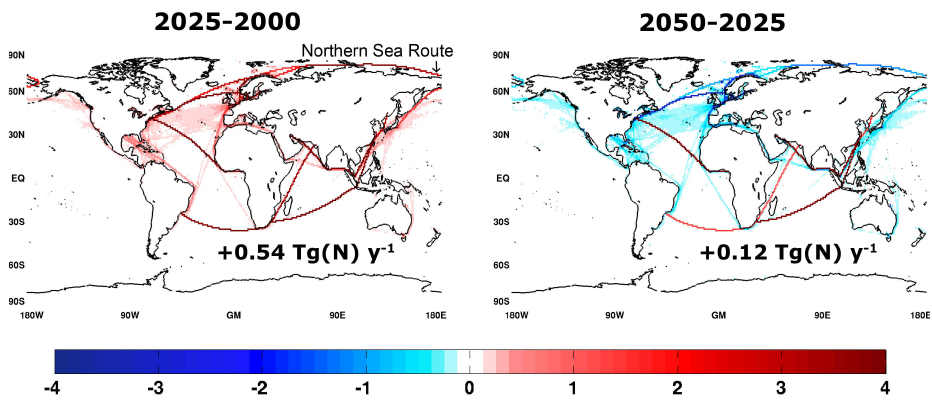
Fig. 3. Spatial distribution of the absolute difference in NO x emission flux from shipping for the B1 scenario (unit: 10 13 1 molecules NO 2 m − 2 s − 1 ) used in